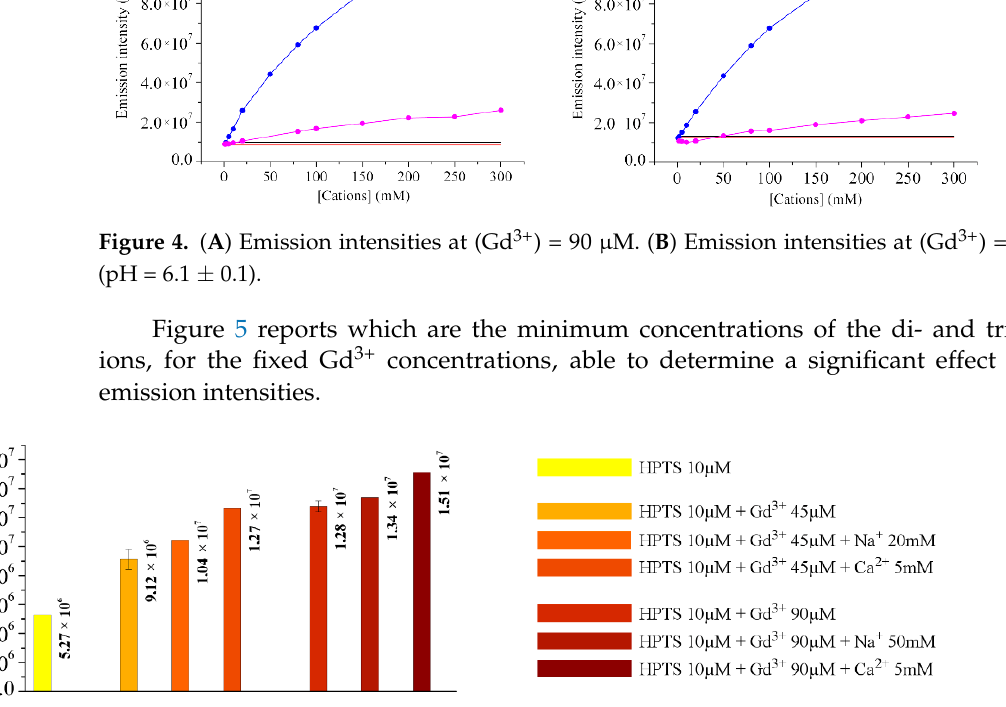
Figure 5. Column plot comparing the extrapolated emission intensities of the samples. This defines for each experimental condition the minimum concentration of mono- and divalent cations able to induce the matrix effect.